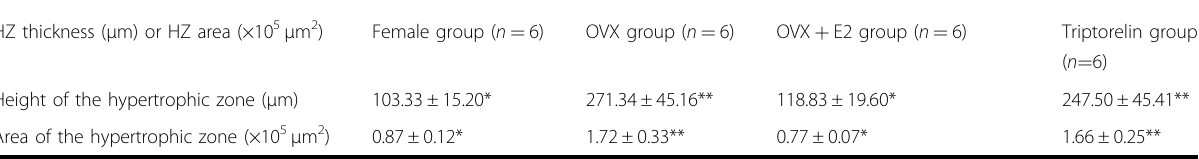
Table 3 Histomorphometry of the hypertrophic zone in the growth plate of the four